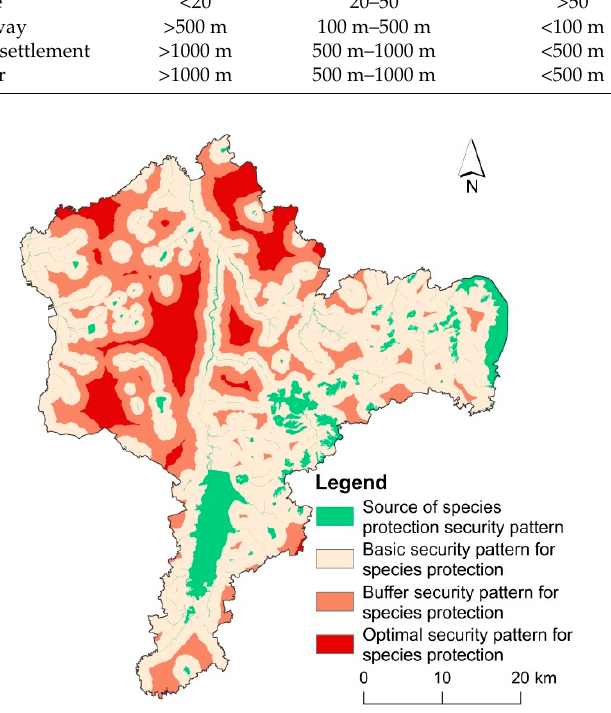
Figure 5. Species protection security pattern.